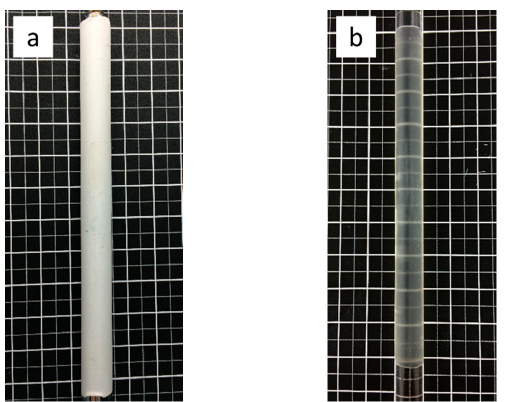
Figure 1. Two grafts: ( a ) polyester (PET) woven graft; ( b ) polyurethane (PU) tubular membrane graft.